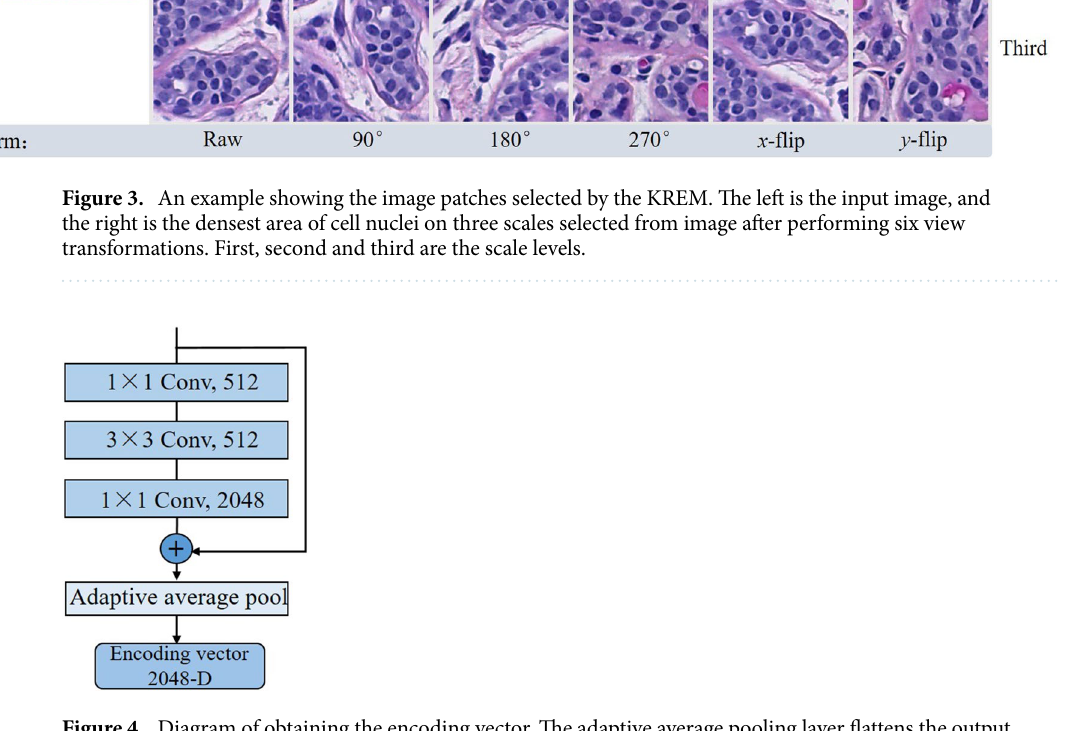
augmentation methods, this step is based on the data augmentation achieved by our proposed sliding window nuclei density detection technique. This can reduce invalid patches and preserve the information of the lesions.